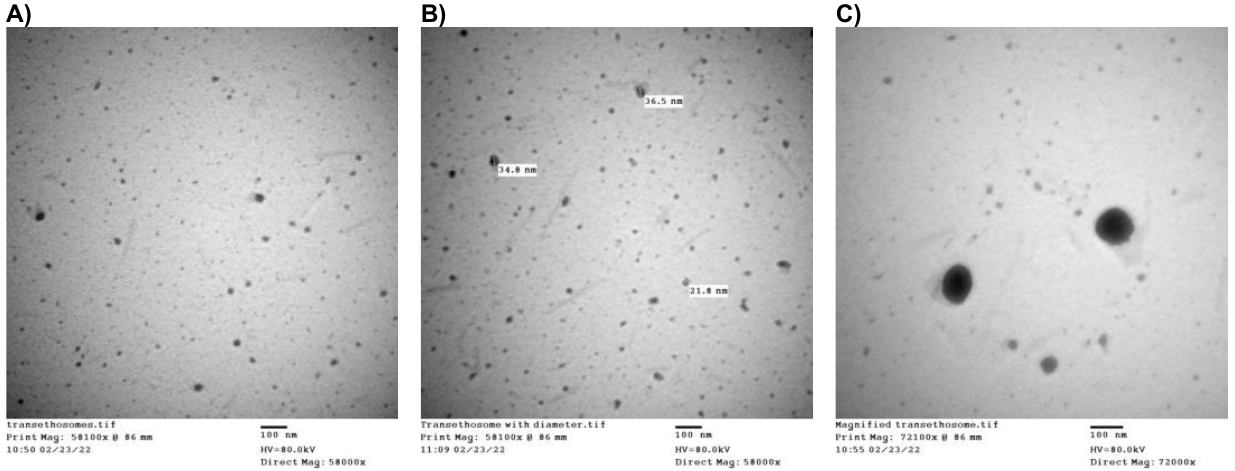
Figure 3. TEM images of the selected CXB-TES formulation (F4). The scale bar represents 100 nm. ( A ) TEM image of the CXB-TES, which showed spherical NPs appearing as spots, ( B ) Size measure- ment of the CXB-TES by TEM, and ( C ) CXB-TES with high magnifications 72,000 ×.